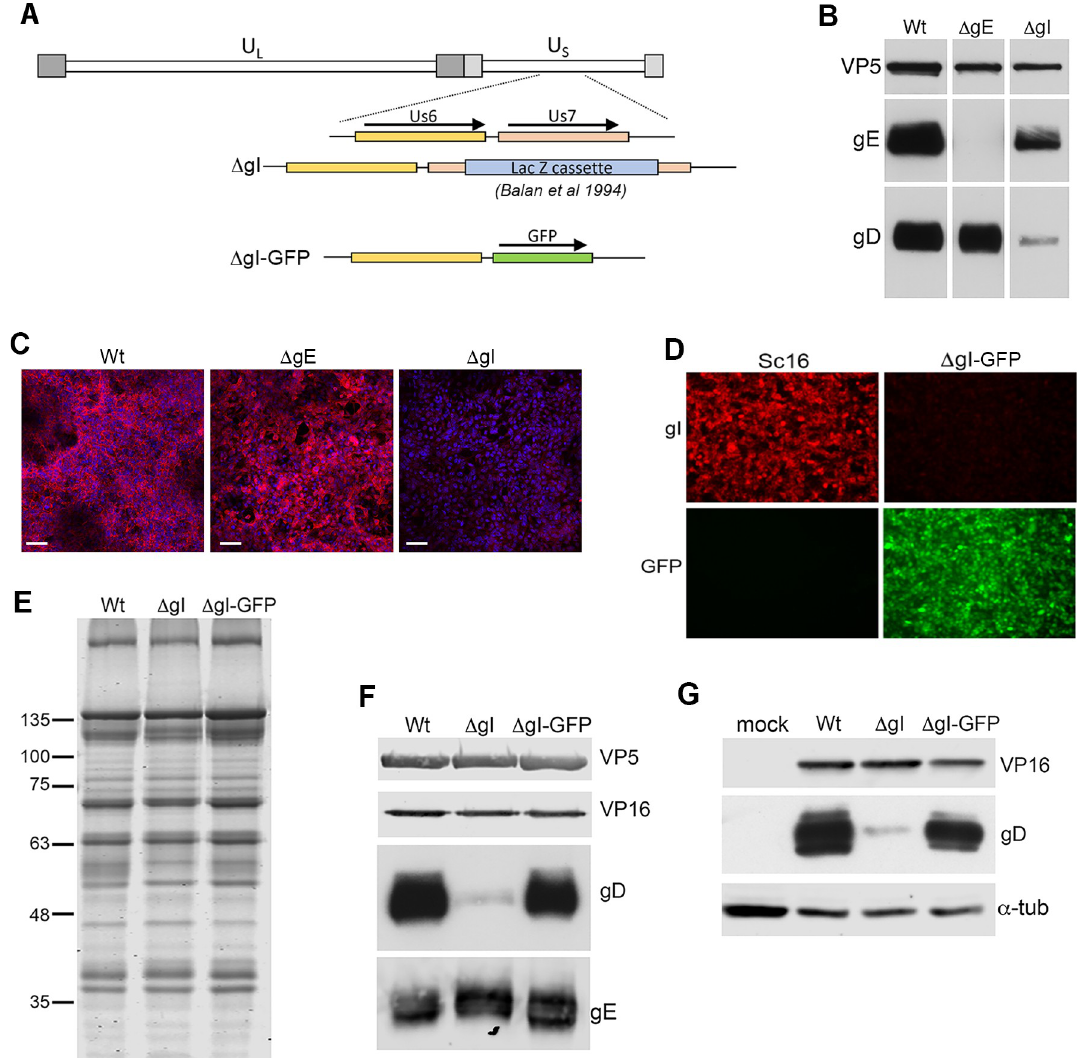
Fig 7. Differential gD expression in two independently generated gI deletion viruses. (A) Line drawing of the Sc16 Δ gI genome that was first described in [18], and the Δ gI-GFP constructed here by replacing the gI gene Us7 with the open reading frame for GFP using homologous recombination. The proximity of the gD-encoding gene Us6 is also indicated. (B) Extracellular virions were purified from HaCaT cells infected with Sc16 (Wt), Δ gE or Δ gI, and analysed by Western blotting for the major capsid protein VP5, and glycoproteins gE and gD. (C) nTERT cells infected with Sc16 Δ gE or Δ gI were fixed and permeabilised at 16 hours, and imaged for gI (stained in red) and nuclei stained with DAPI (blue). Scale bar = 100 μ m. (D) Cells infected with Sc16 or Δ gI-GFP were fixed and permeabilised at 16 h, and imaged for gI (stained in red) and GFP (green). ( E) and (F) Extracellular virions were purified from HaCaT cells infected with Sc16 (Wt), Δ gI or Δ gIGFP, and analysed by SDS-PAGE followed by staining with (E) Coomassie blue or (F) Western blotting for VP5, VP16, gD and gE. (G) nTERT cells infected with Wt, Δ gI or Δ gIGFP viruses were harvested at 16 h and analysed by SDS-PAGE and Western blotting for VP16, gD and α -tubulin.